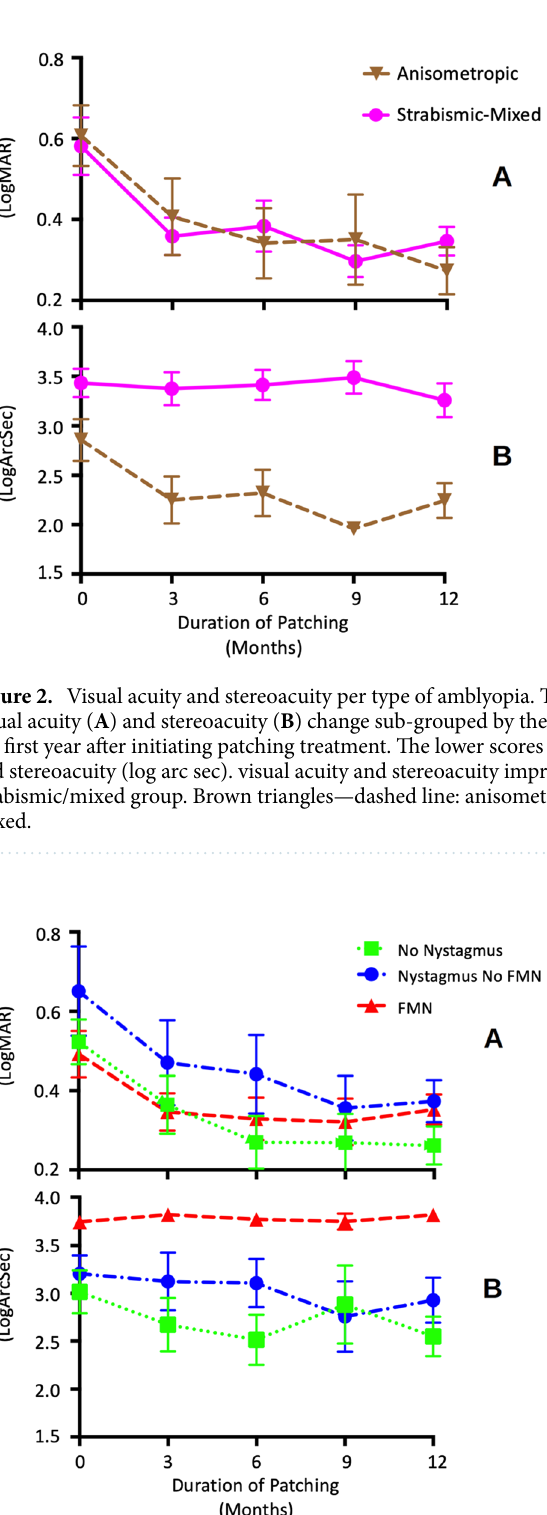
Figure 3. Visual acuity and stereoacuity per fixational eye movements characteristcs. The mean and standard error of mean of visual acuity ( A ) and stereoacuity ( B ) change sub-grouped by the fixation eye movement characteristics at baseline and during the first year after initiating patching treatment. The lower scores indicate better visual acuity (log MAR) and stereoacuity (log arc sec). Visual acuity and stereoacuity improvement was greater in patients without nystagmus. No improvement of stereoacuity was recorded in FMNS group. Green squares: no nystagmus; blue circles: nystagmus no FMNS; red triangles: